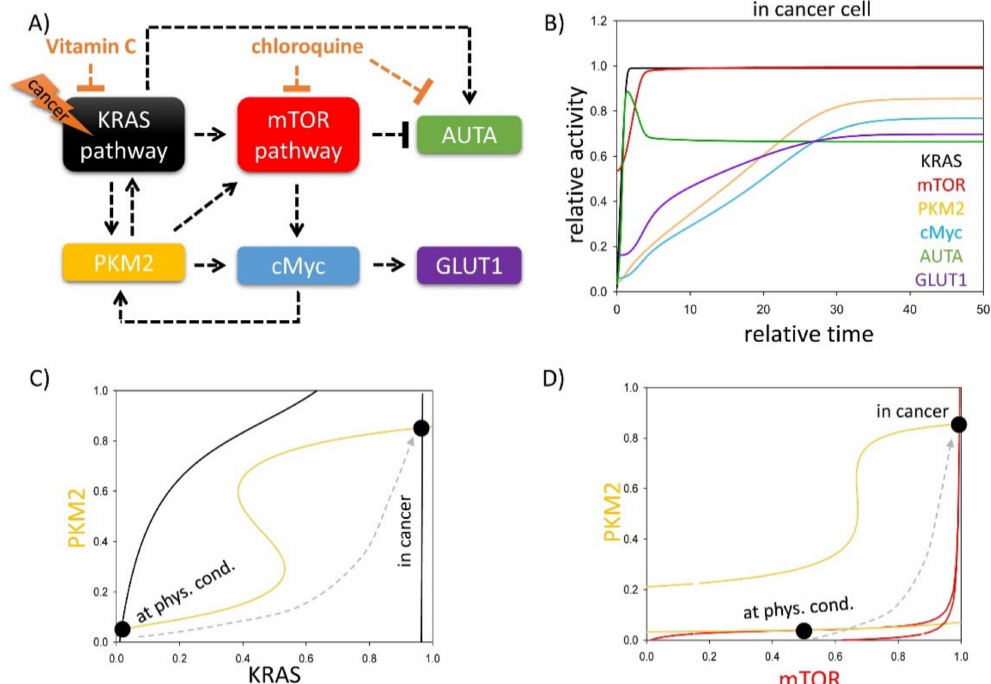
Figure 1. Both KRAS and mTOR pathways have key roles in determining autophagy induction and GLUT1 transport upon various cellular stress events. ( A ) The key regulatory components and their interactions at various stress events. Autophagy refers to those elements which can induce autophagy with respect to cellular stress, while cell death inducer means the sum of the activators of cellular cell death process. Dashed lines show how the molecules can influence each other. Blocked end lines denote inhibition. ( B ) The computational simulations are determined in KRAS mutant cancer cells. The temporal dynamics are simulated with karas = 1. The relative activity of KRAS, PKM2, mTOR, cMyc, autophagy (AUTA) and GLUT1 is shown. The ( C ) PKM2–KRAS and ( D ) PKM2–mTOR signal–response curves are plotted in physiological conditions (karas = 0.1) and in cancer cells (karas = 1). Intersections of nullclines represent the stable (filled circle) steady states. Trajectories are depicted with dashed grey lines. For detailed descriptions of the elements and constants of the theoretical models, see Tables A1 and A2,